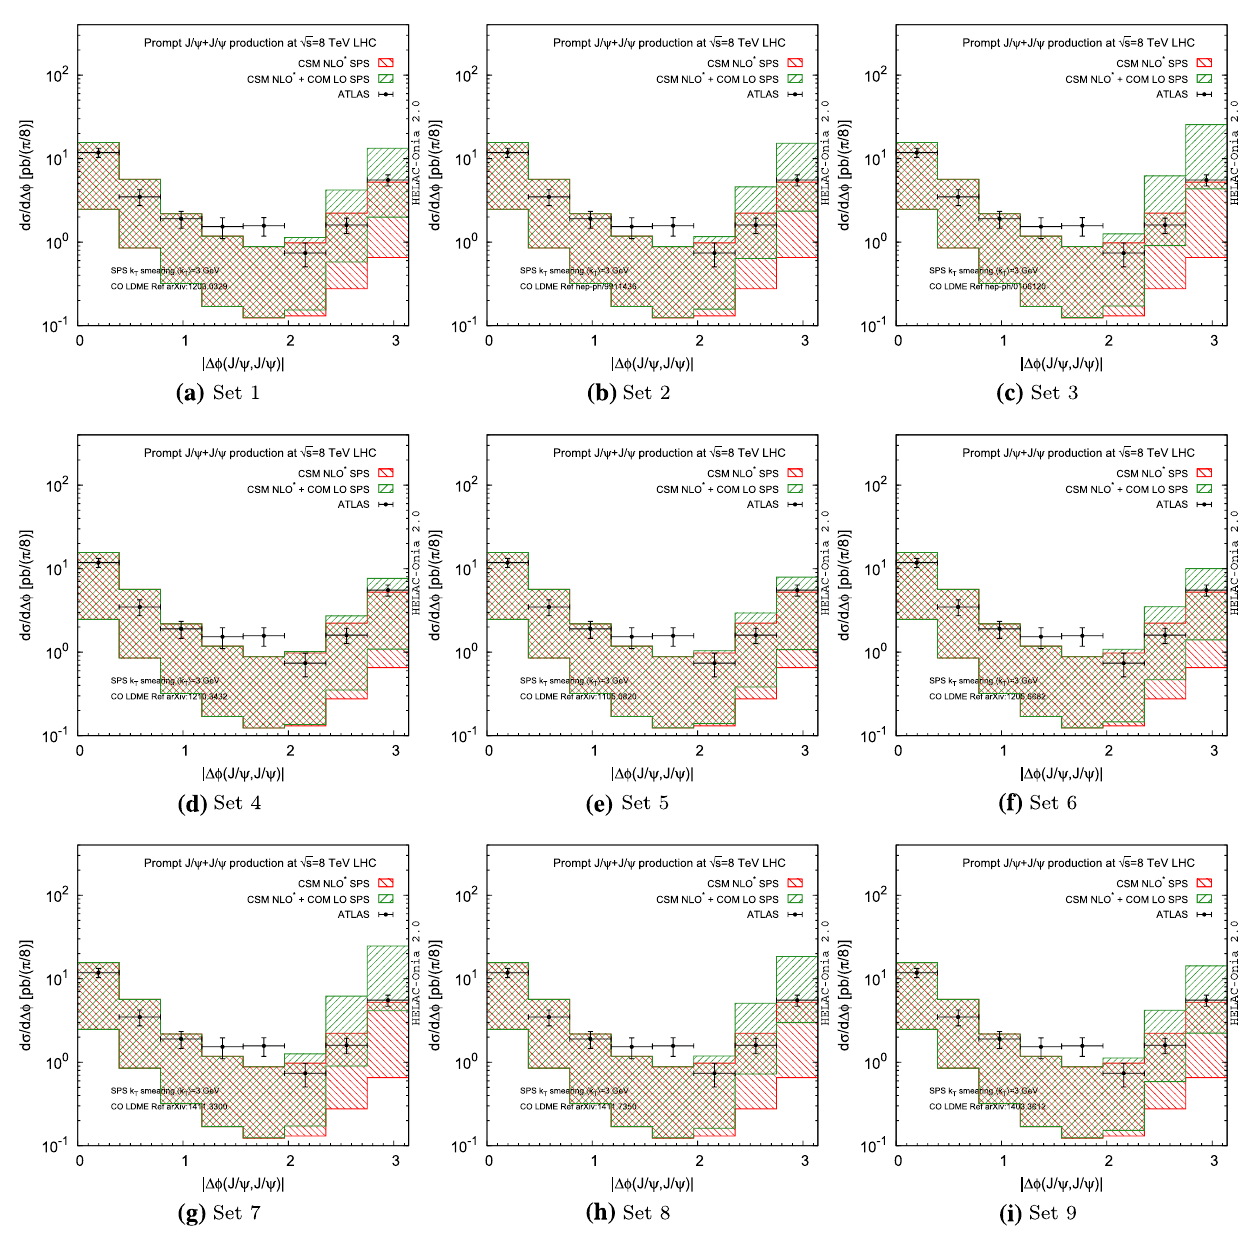
√ s = 8 TeV acceptance